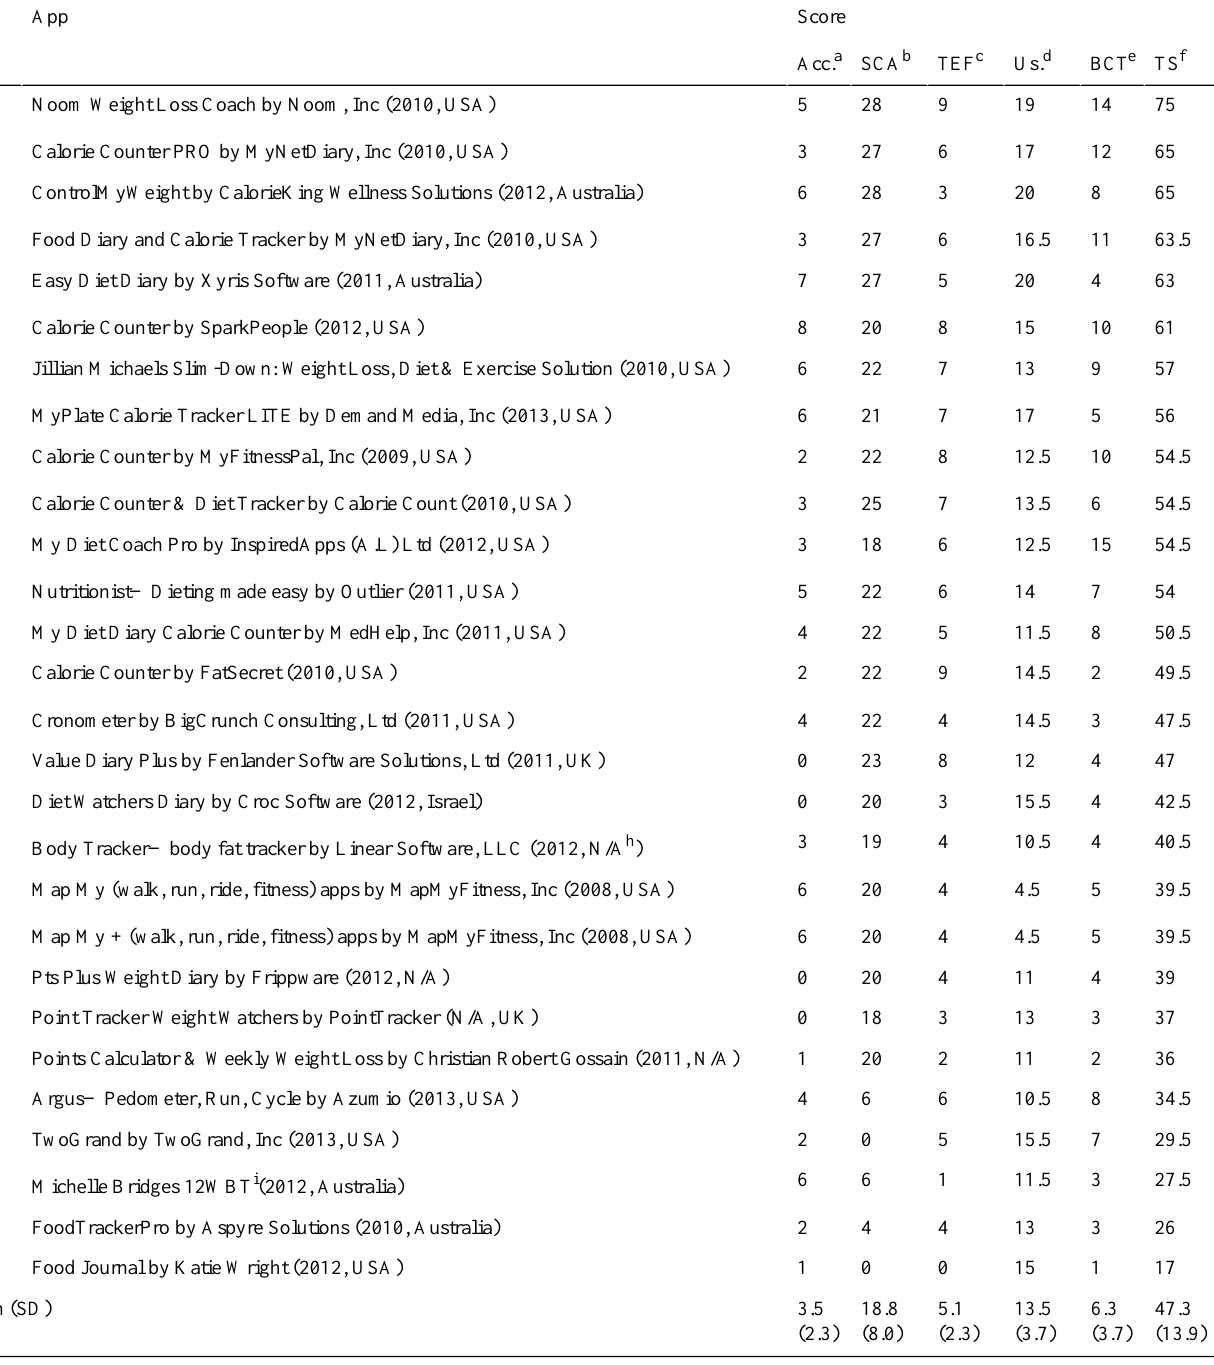
Table 2. Relative ranking of popular dietary weight-loss smartphone apps. Ranking was determined according to their total score which was calculated from the sum of the scores for each component of the quality assessment